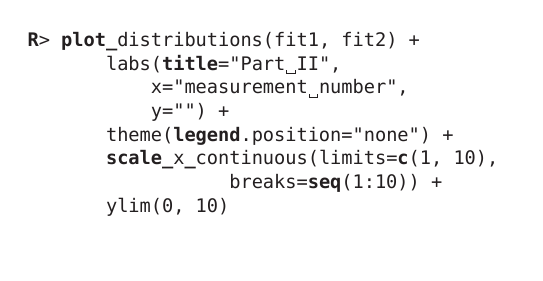
R > plot_ distributions(fit1, fit2) + labs( title ="Part